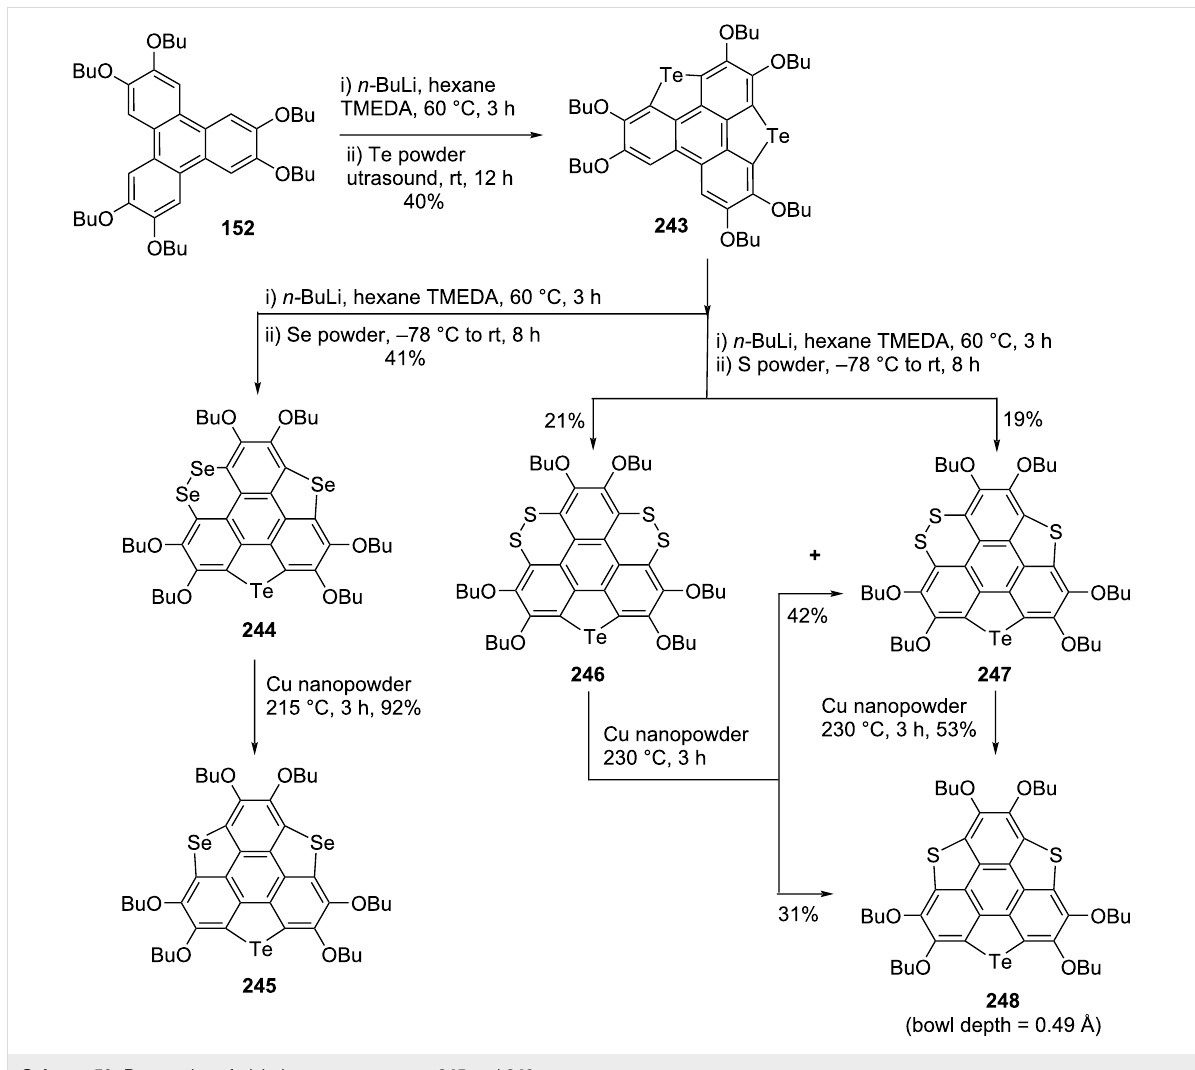
Scheme 59: Preparation of trichalcogenasumanenes 245 and 248